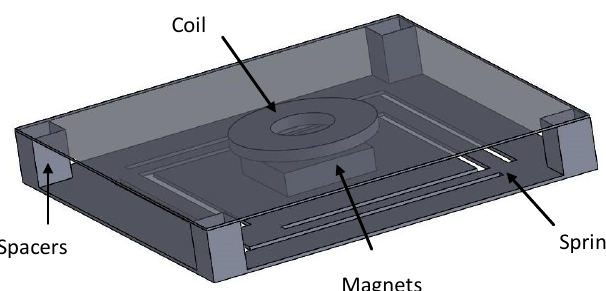
Figure 1. Electromagnetic energy harvester device proposed by Mallick et al . [27].